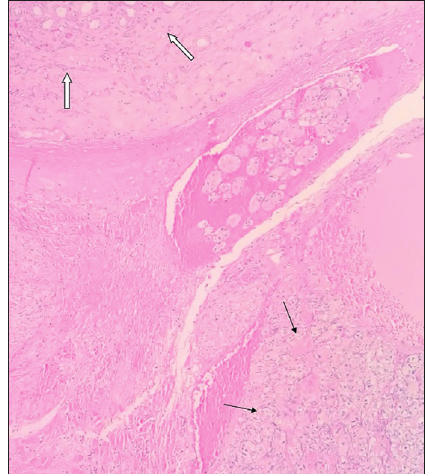
Figure 4. Low power view of the tumor detected in the testis (black arrows). The tumor